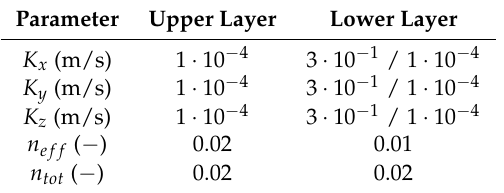
Table 1. Adopted model parameters based on the calibration